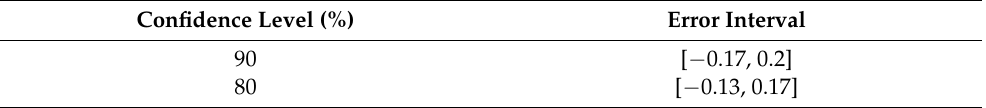
Table 4. Error interval of kernel density estimation.